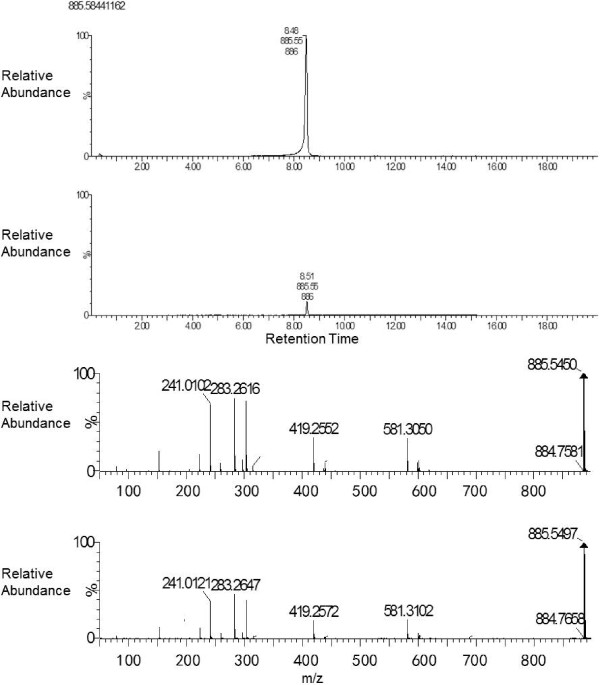
Chromatography and MS/MS spectra of ion m/z 885.5499 (PI(18:0/20:4(5Z,8Z,11Z,14Z)) from the purchased standard (top chromatogram and spectra) and a sample (bottom chromatogram and spectra). Fragmentation patterns match at major peaks 885- parent ion, 581- parent ion with loss of sn-2 arachidonic acid side chain m/z 303, 303- liberated arachidonic acid, 283- liberated stearic acid, and 241- inositol head group.